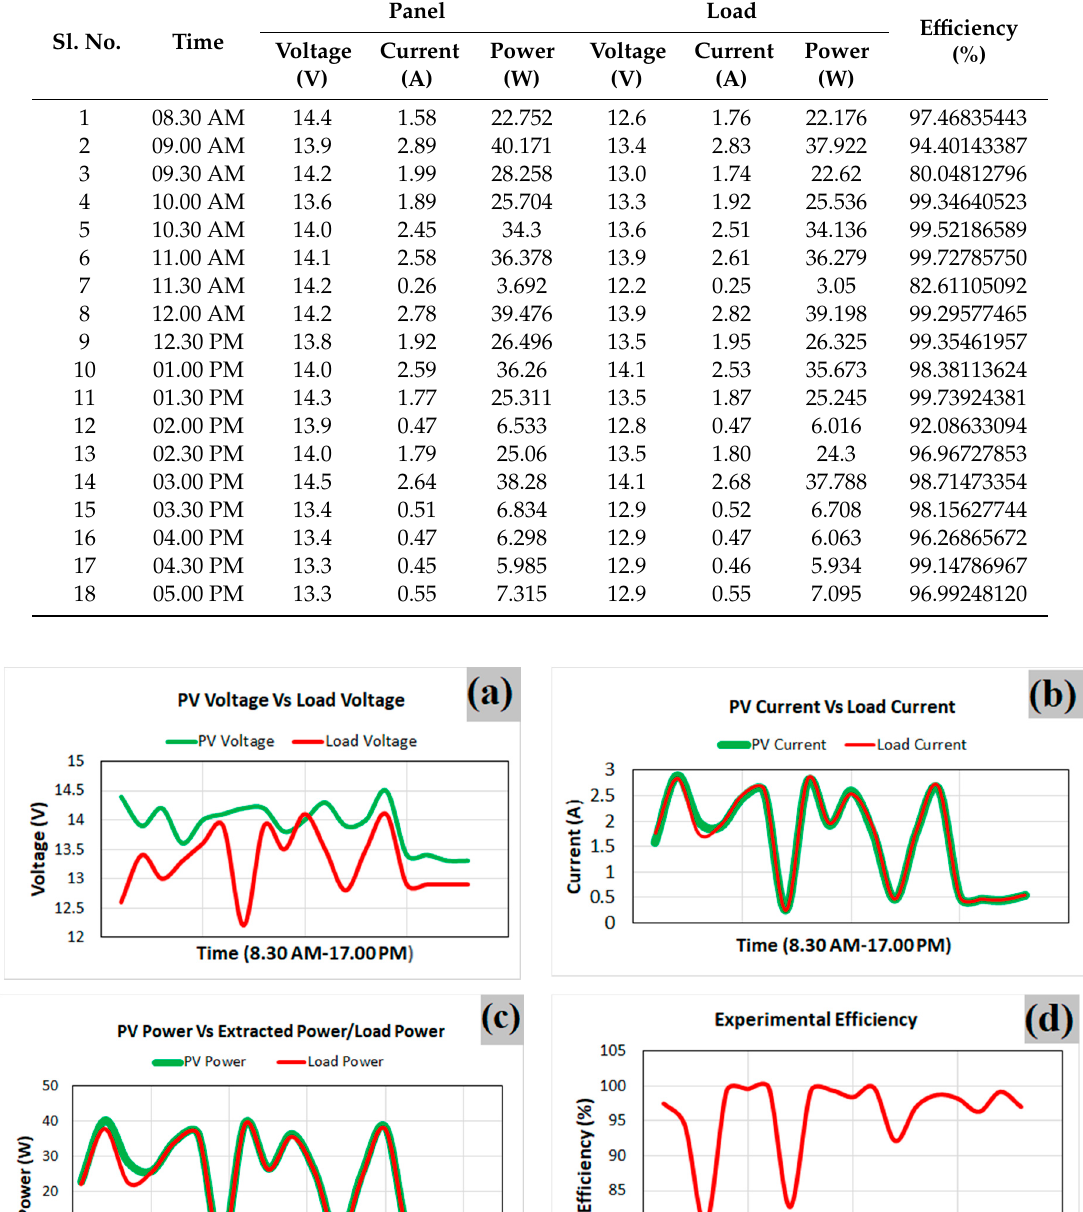
Table 2. Experimental results achieved from the proposed charge controller. Sl. No.